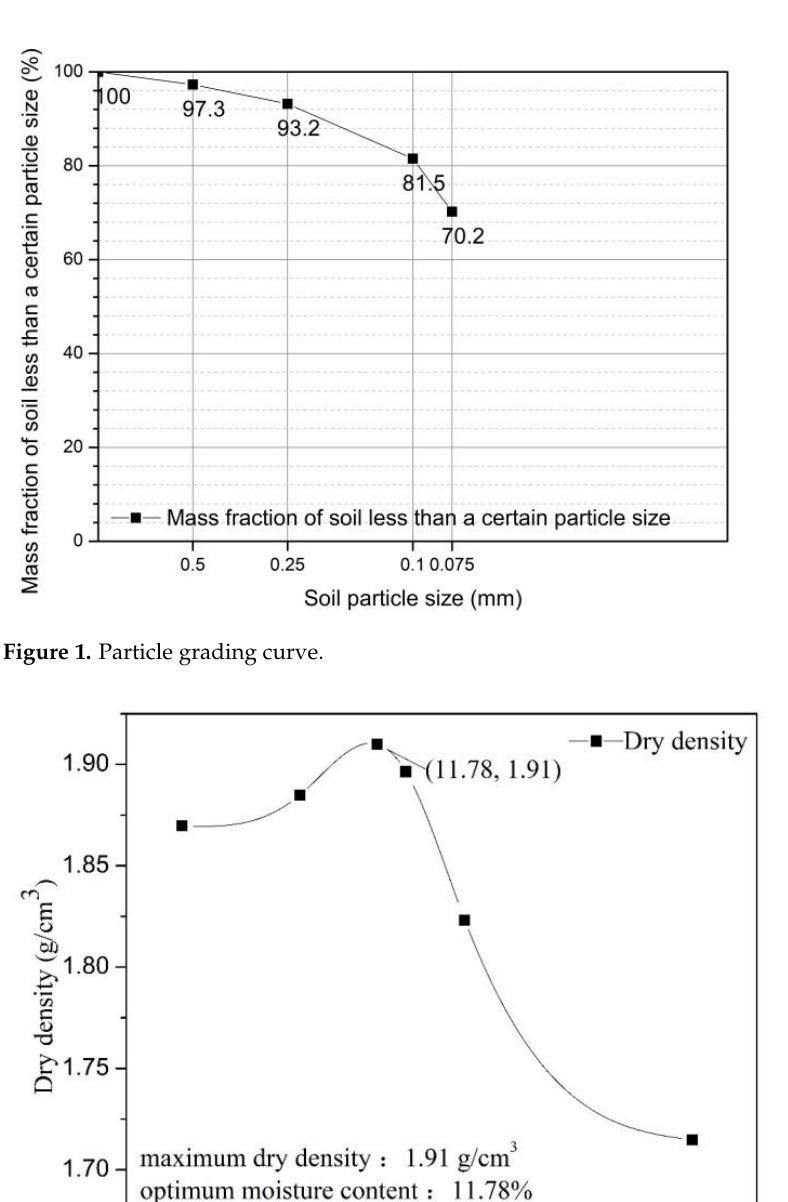
Table 2. Main chemical components of undisturbed soil.